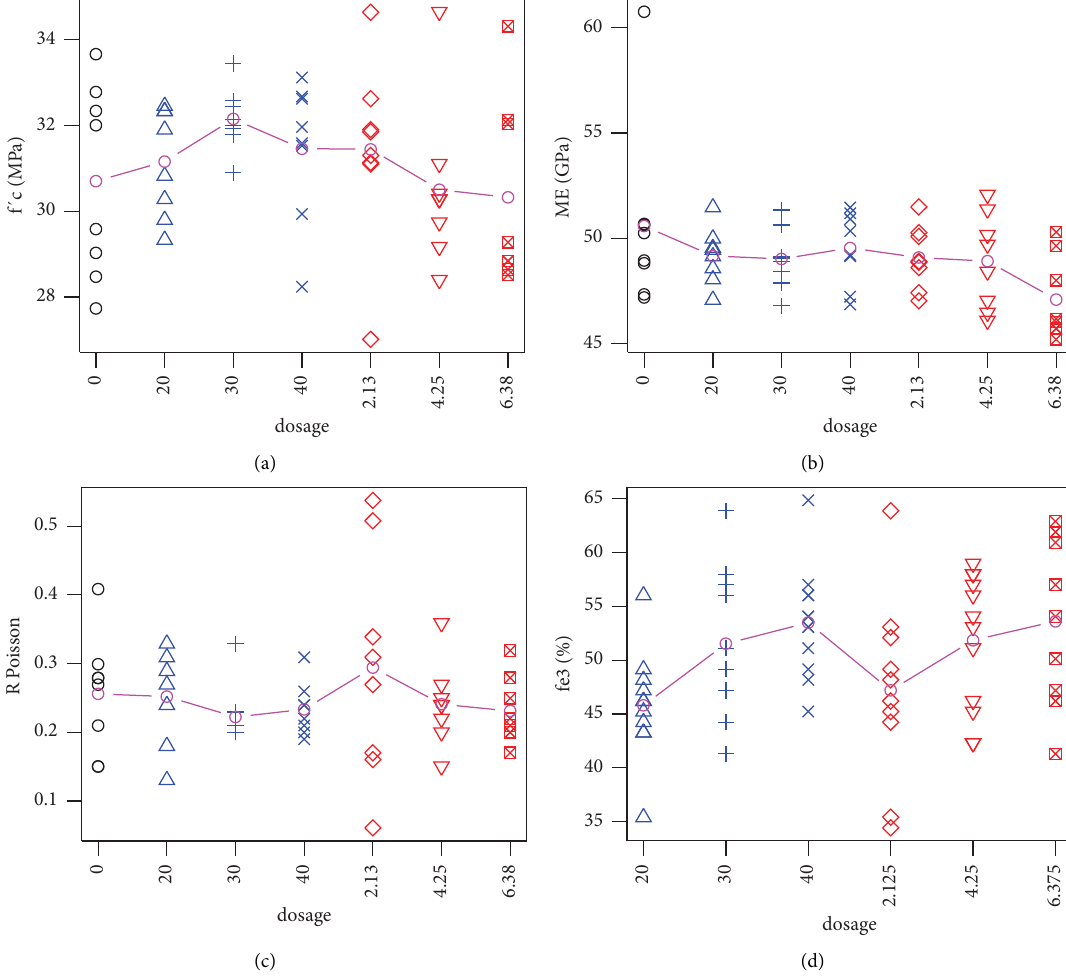
Figure 9: Graph of the results. (a) Compressive strength. (b) Modulus of elasticity. (c) Poisson’s ratio. (d) Residual